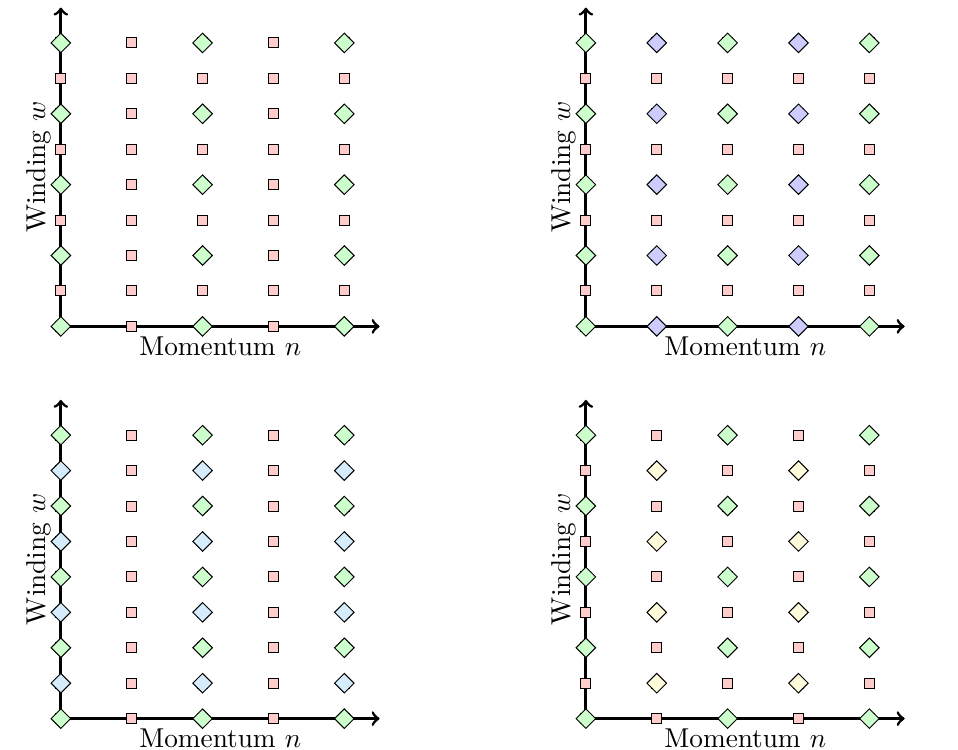
symmetry, and the 2 [ R ] by the n